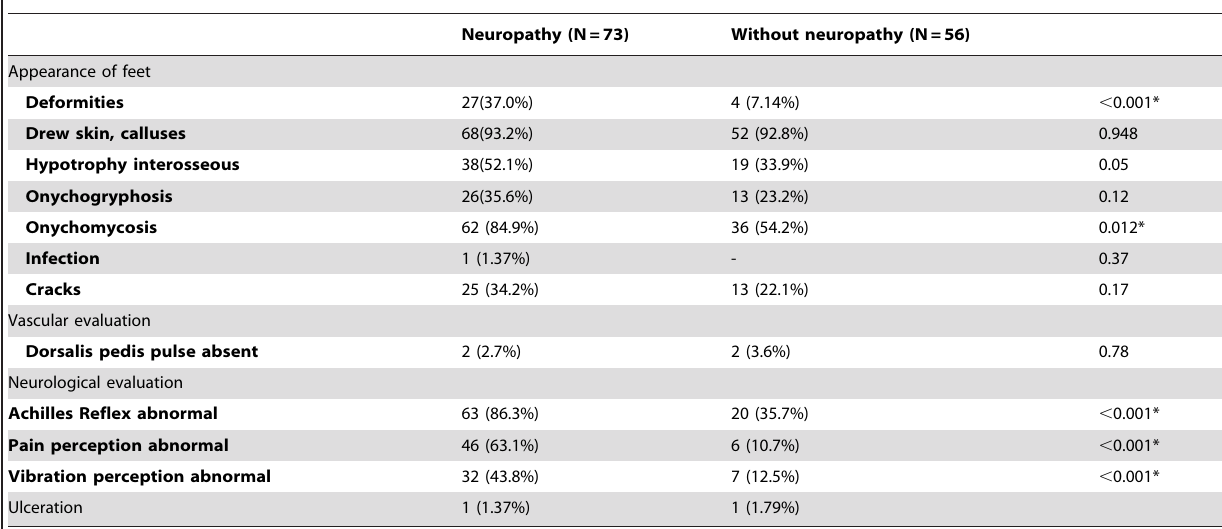
Table 2. Characteristics of foot